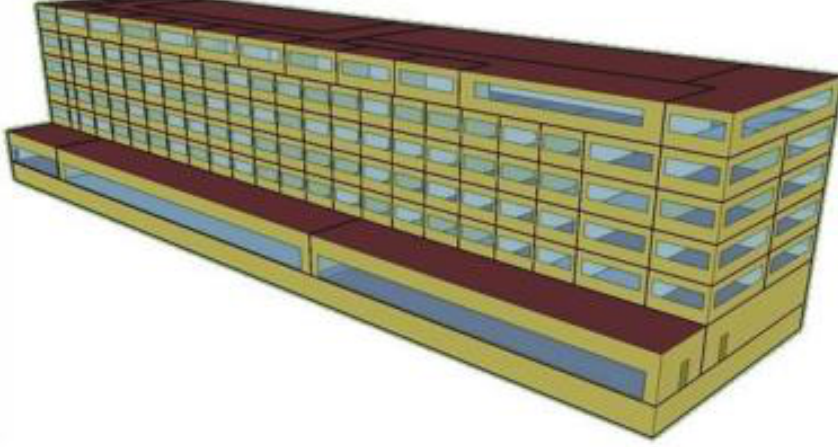
Figure 4. Large hotel at Ohio State University used in the study.